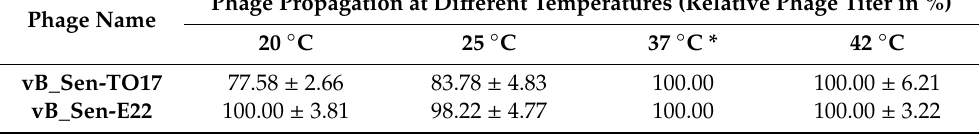
Table 6. E ffi cacy of phage plating of phages vB_Sen-TO17 and vB_Sen-E22 at di ff erent temperatures. Control temperature is marked with an